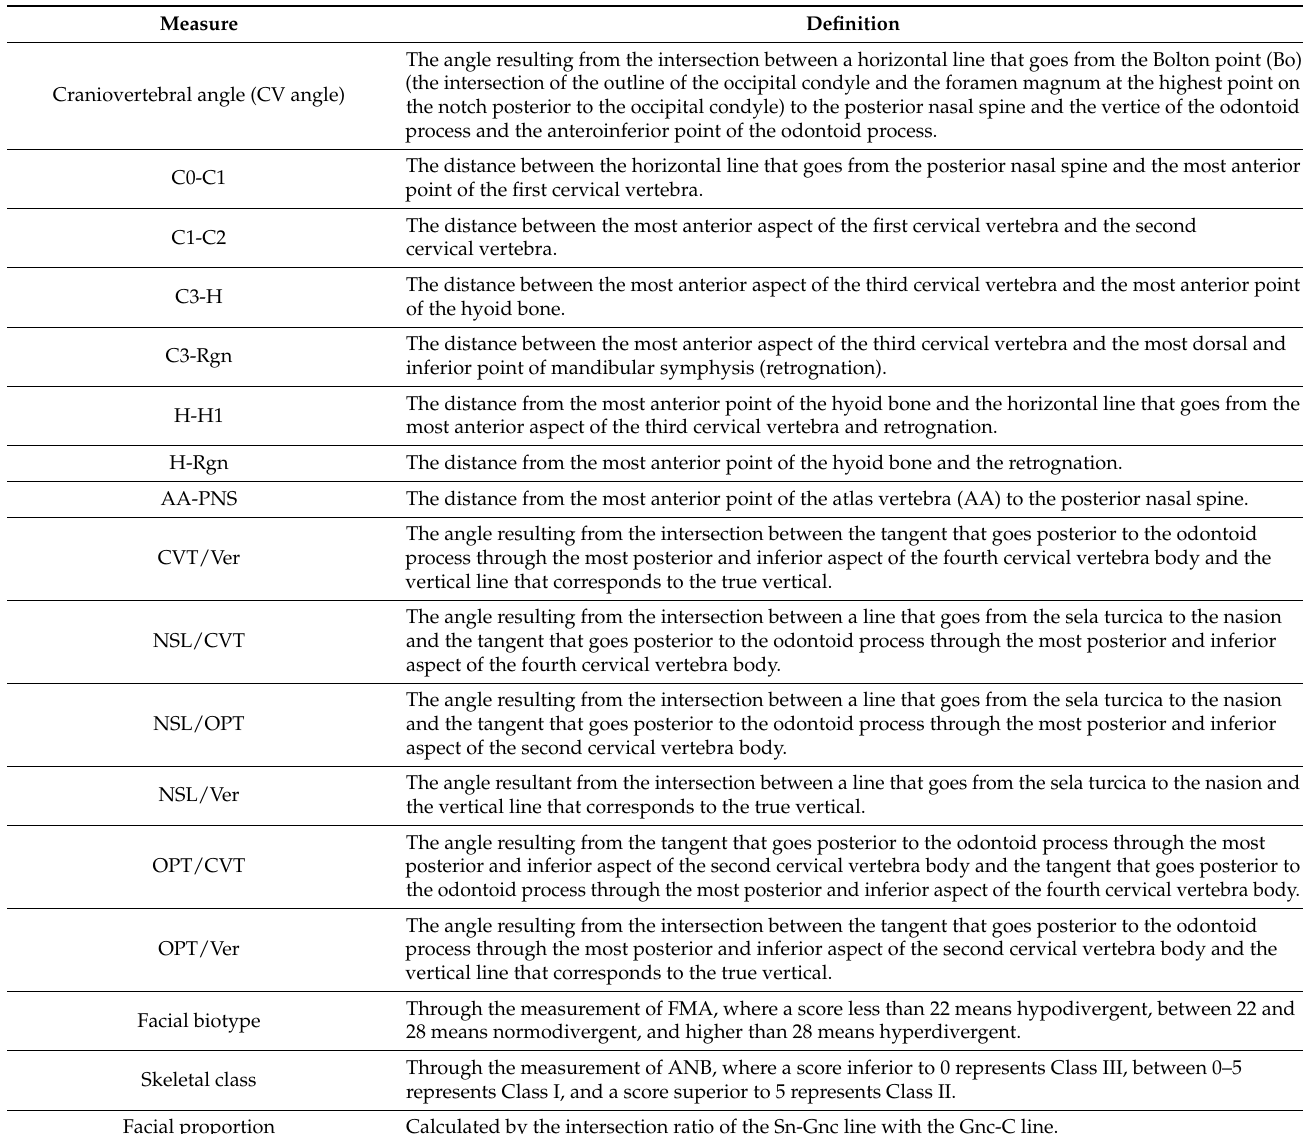
Table 1. Cephalometric landmarks, angles, and reference